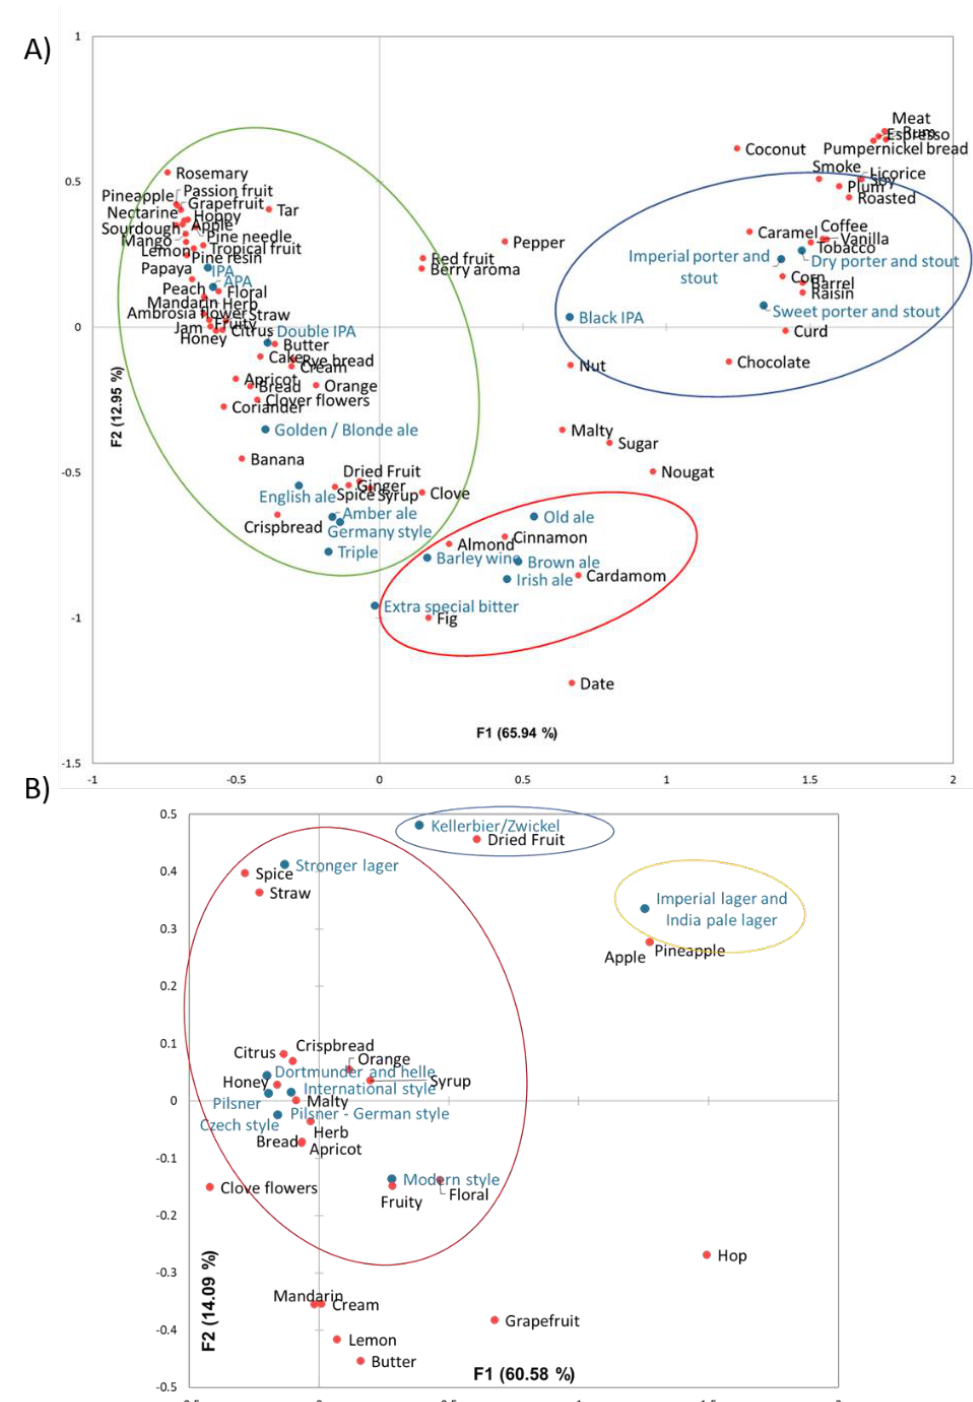
Figure 5. ( A ) Correspondence analysis (CA) biplot illustrating the distribution of the different ale styles based on the frequency of citation of sensory descriptors. ( B ) Correspondence analysis (CA) biplot illustrating the distribution of the different lager styles based on the frequency of citation of sensory descriptors. For each biplot, scores (colored in blue with blue dots) represent beer styles, whereas loadings (colored in black with red dots) represent sensory descriptors. Ellipses in different colours represent the clusters found with the corresponding hierarchical cluster analysis (HCA). IPA stands for Indian Pale Ale; APA stands for American Pale